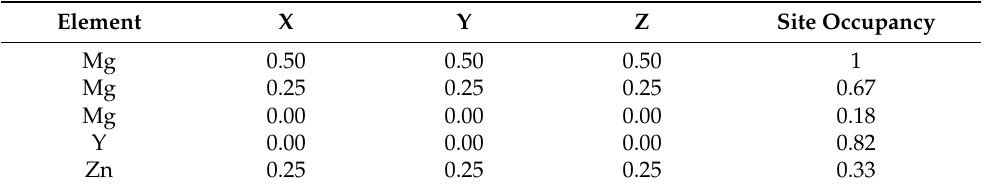
) and triangle ( (cid:72) ), (cid:35)